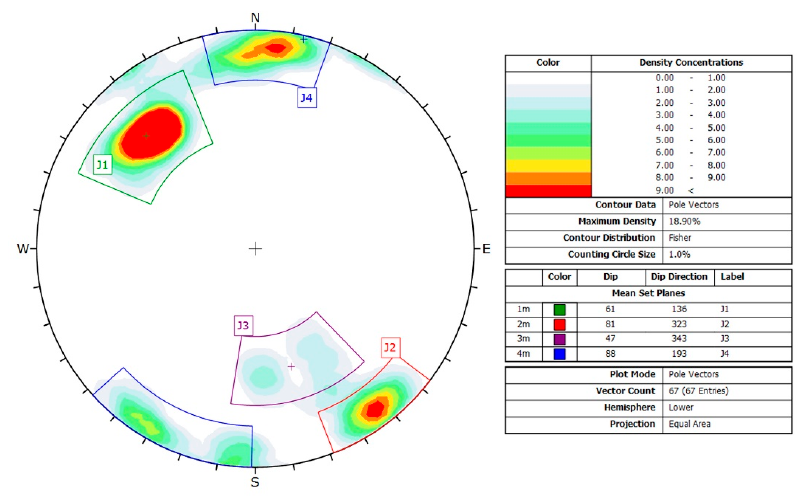
Figure 4. Final stereonet plot of discontinuity poles measured from remote sensing and traditional surveys: joint set sub-division after density analysis is highlighted. Table 2. Mean orientation values of discontinuity sets measured on the study area.